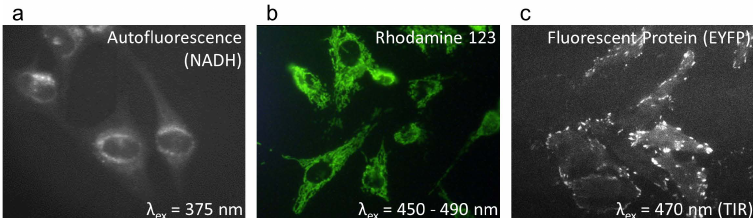
Figure 6. Wide-field fluorescence microscopy of 2D cell cultures: ( a ) Autofluorescence of U251-MG glioblastoma cells (dominated by the coenzyme NADH); ( b ) BKEz-7 endothelial cells incubated with the fluorescent marker rhodamine 123 (5 µ M, 45 min.); ( c ) HeLa cervical carcinoma cells transfected with enhanced yellow fluorescent protein (EYFP) linked to Paxilline upon Total-Internal-Reflection (TIR) excitation (wide-field microscopy with a 40 /0.75 microscope objective lens). ×